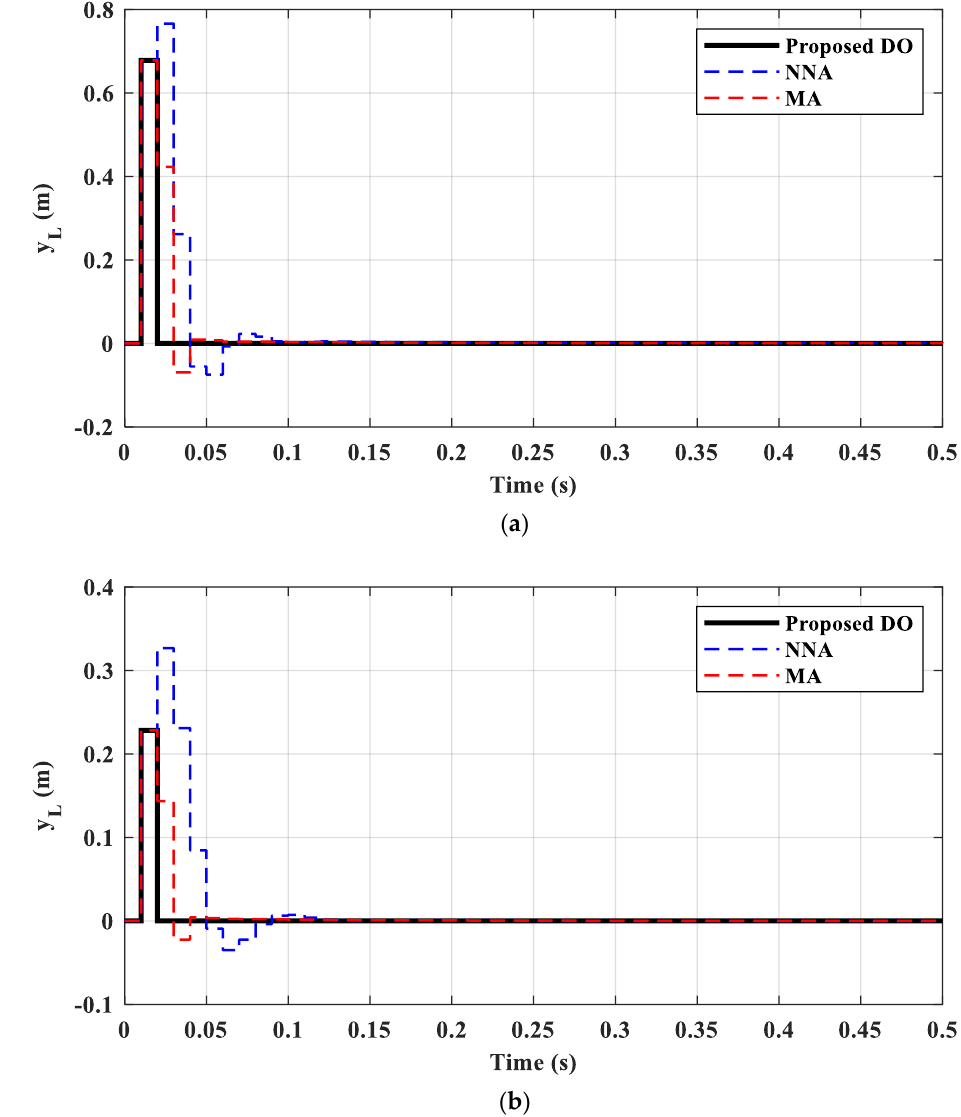
Figure 13. The output response of the AV lateral deviation against the look-ahead distance variations of the vision system ( a ) +5 m increasing, ( b ) − 5 m decreasing.